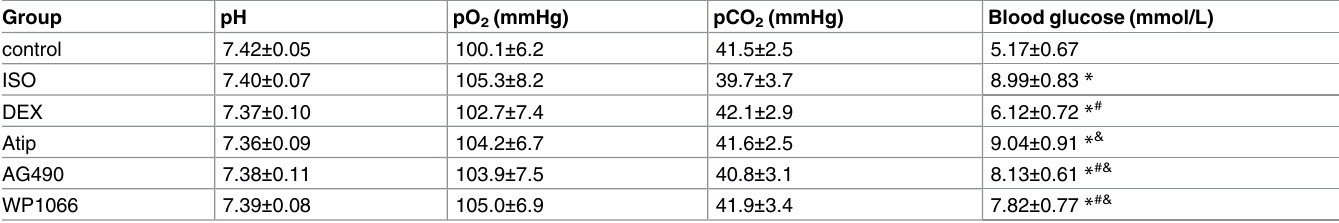
Groups were treated as described in Methods. Data are represented as mean ± SD (n =